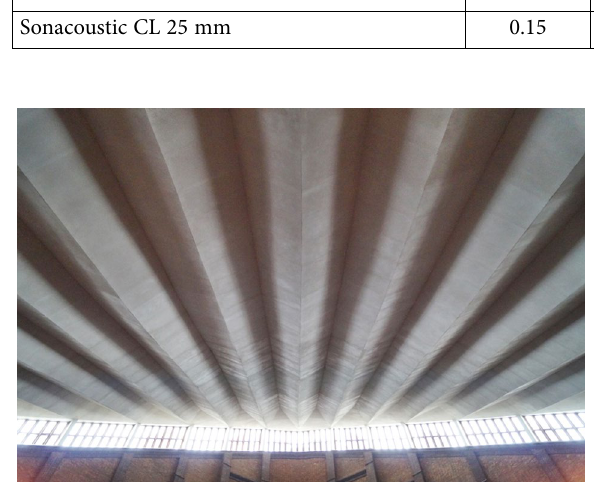
Figure 9. View of the accordion-like structure of the